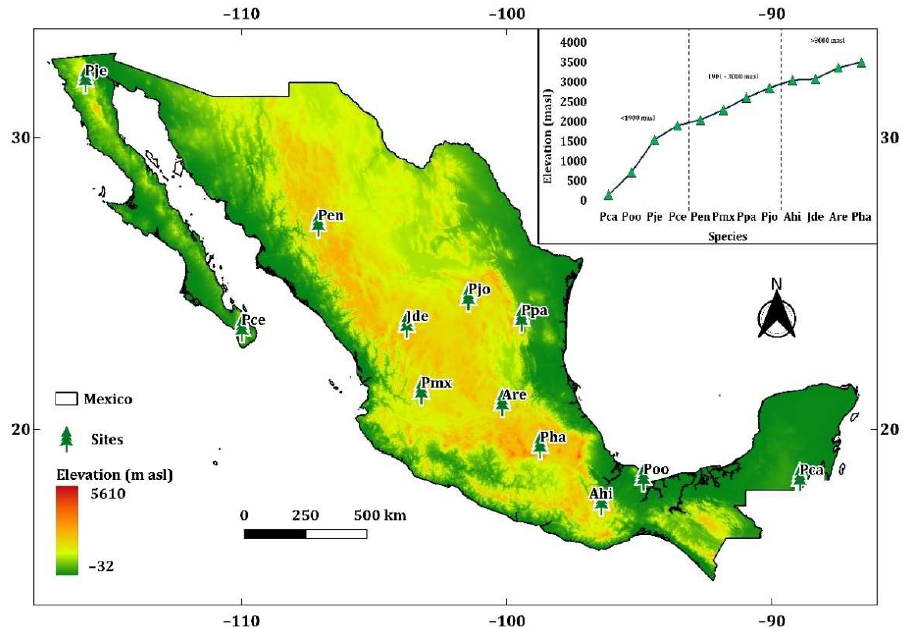
Figure 1. Location of sampling sites of: Pinus caribaea var. hondurensis Barret & Golfari (Pca); Pinus oocarpa Schiede ex Schltdl. (Poo); Pinus jeffreyi Grev. & Balf. (Pje); Pinus cembroides subsp. lagunae (Rob. Pass.) D.K. Bailey (Pce); Pinus engelmannii Carr. (Pen); Pinus maximartinezii Rzedowski (Pmx); Pinus patula Schltdl. et Cham. (Ppa). Pinus johannis M.-F. Robert-Passini (Pjo); Abies hickelii Flous & Gaussen (Ahi); Juniperus deppeana Steud. (Jde); Abies religiosa Kunth Schltdl. et Cham. (Are); and Pinus hartwegii Lindl. (Pha). Ramp color depicts elevation range in m asl. Table 1. Dendrochronological statistics per species and characteristics of the sites.